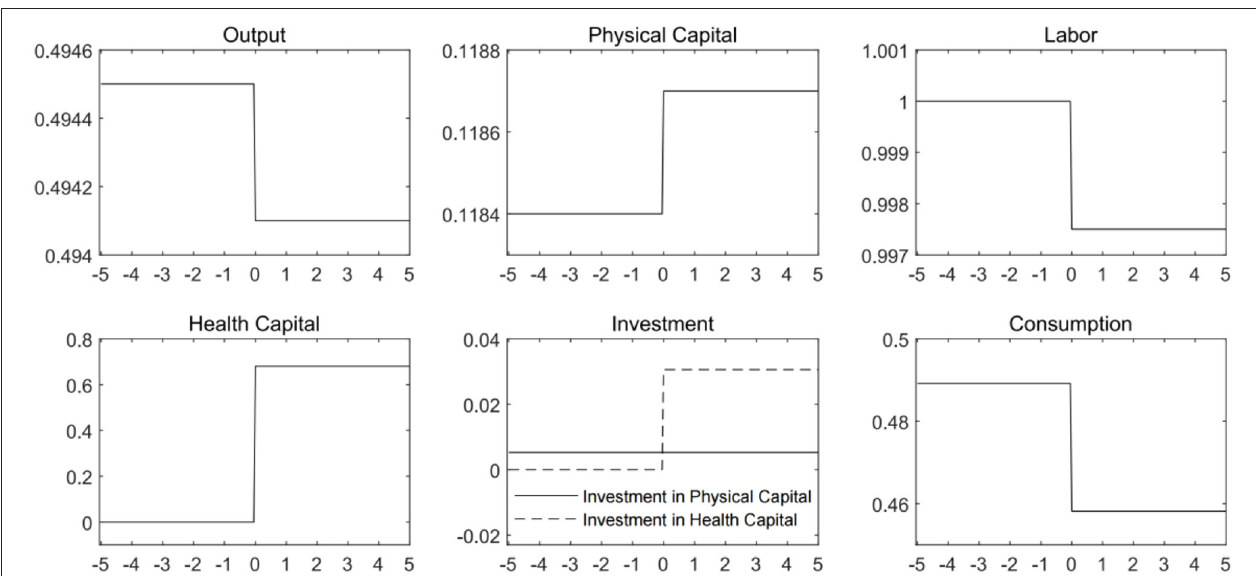
FIGURE 2 | Economic steady states and pandemic shock. It is assumed that the pandemic shock hit the economy at time t = 0. Before that, the economy is not subjected to any infectious